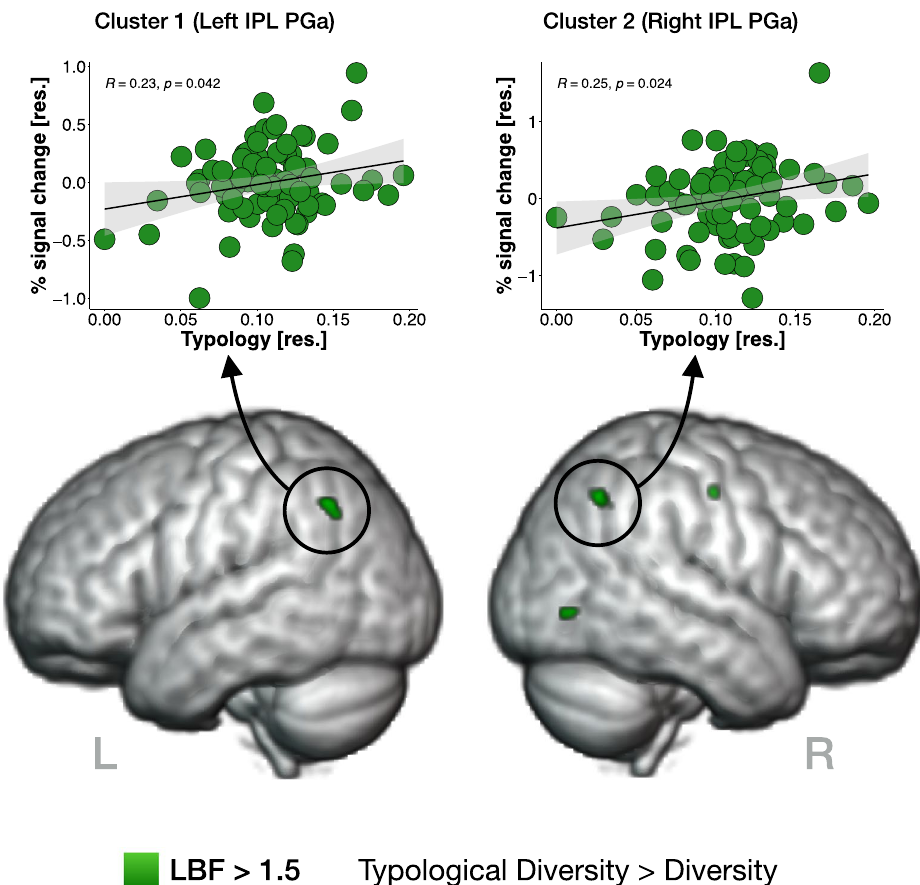
Figure 3. Effect of language typology: presented on the bottom are clusters of voxels (in green) showing preference for the model including typological information on participants’ language background ("Typological Diversity") over a model accounting for cumulative length of exposure to all languages ("Diversity"). Graphs on top show the percentage signal change values for the BOLD signal recorded during the English Word Match Task in bilateral IPL PGa areas, as a function of residual values of Typology (i.e., Typological Diversity index controlled for covariates of no-interest and length of exposure to all languages). NB. the percentage signal change values in the two remaining clusters are presented in the Supplementary Materials (see Fig.